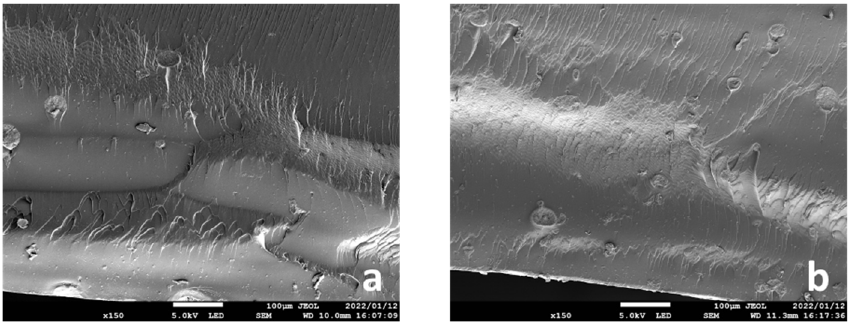
Figure 3. Fracture surfaces (150× microscopic image) of the specimens with ( a ) 5 wt.% and ( b ) 10 wt.% zirconia filler in the 0° printing direction observed after the three-point bending tests. zirconia filler in the 0 ◦ printing direction observed after the three-point bending